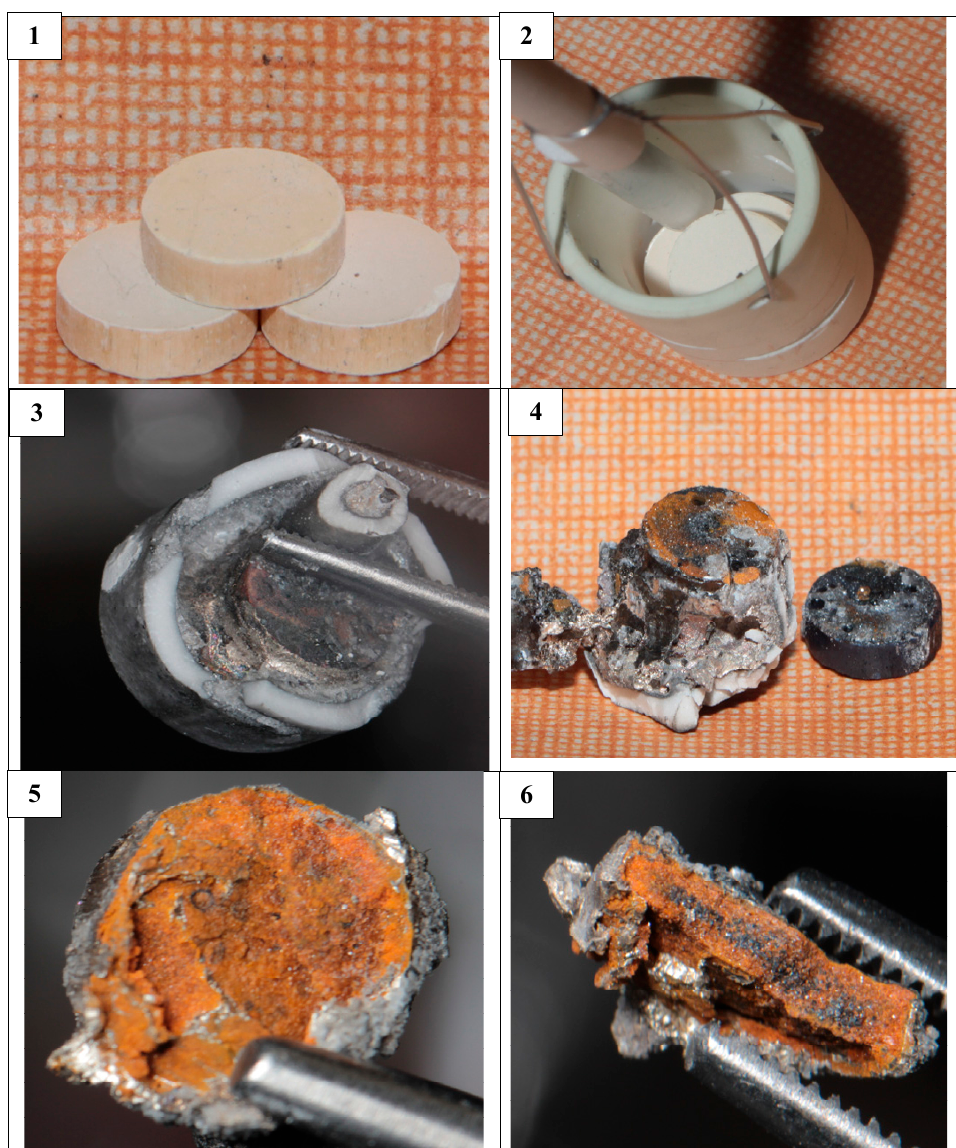
Figure 8. ( 1 ) Pressed and annealed CeO 2 pellets; ( 2 ) CeO 2 pellets in the cathode crucible; ( 3 ) CeO 2 pellets in the Mo cathode after the electrolysis; the crucible walls were broken; ( 4 ) pellets separated from the ceramic crucible together with the Mo current lead; ( 5 ) lengthwise fault of the CeO 2 pellets after the reduction; and ( 6 ) transverse fault of the CeO 2 pellets after the reduction. The initial porosity of the pellets was 20%.